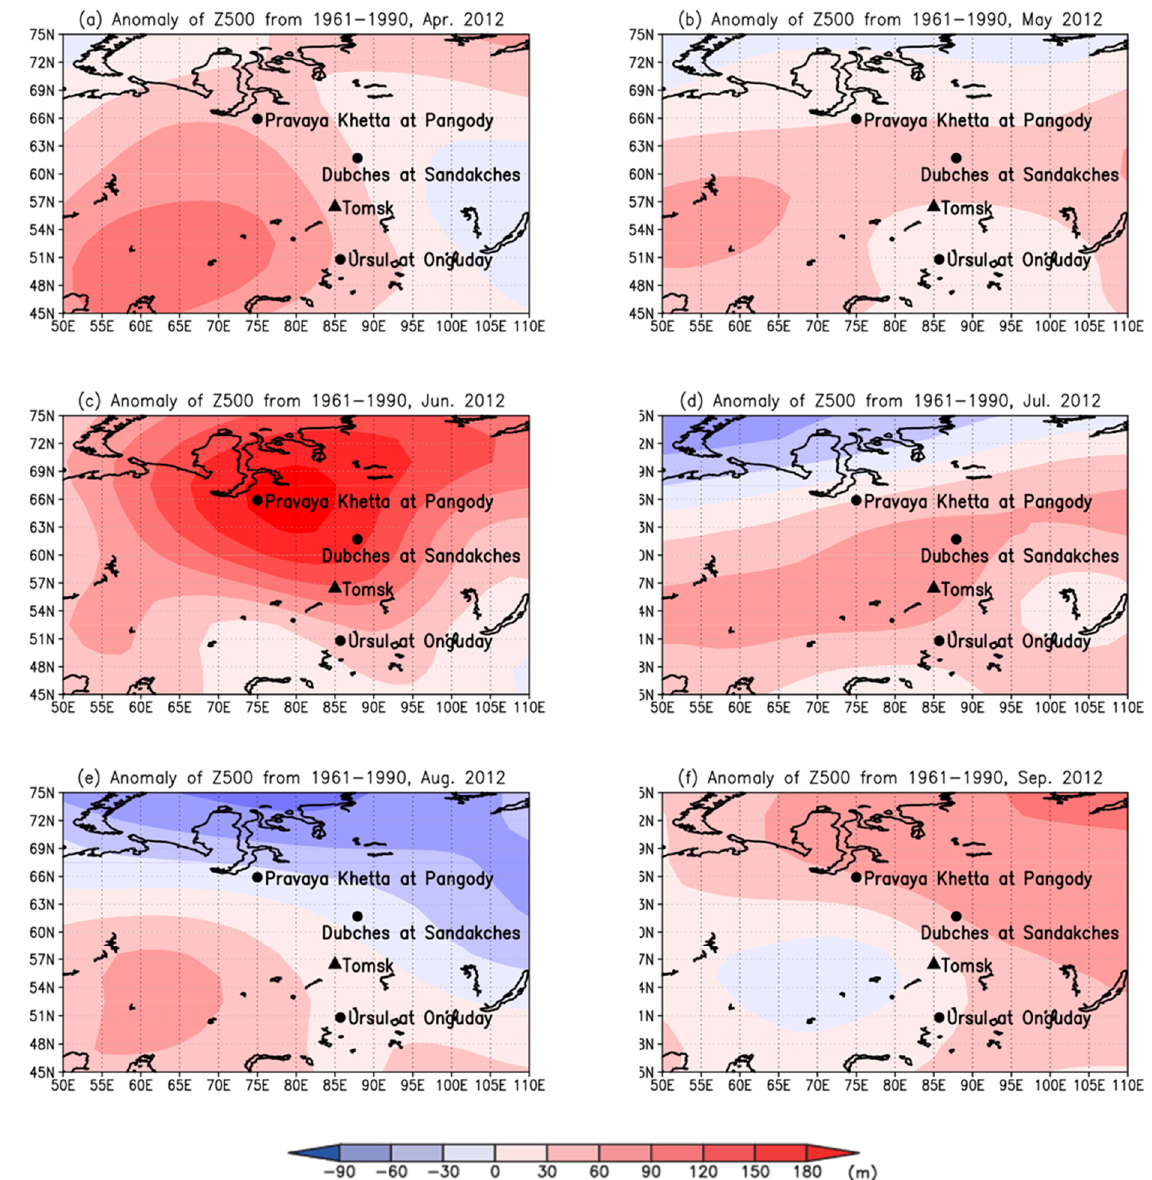
Figure 6. Same as Figure 4, but for geopotential height at 500 hPa. The data source is the same as for Figure 5 [19]. Black circles are experimental basins, whereas black triangle represents Tomsk.In summary, the entire WS experienced a high temperature anomaly from spring to summer in 2012; however, low precipitation was limited to middle WS, especially in June and July. In the next section, we explore the temporal variation in the hydrometeorological characteristics in middle, north, and south